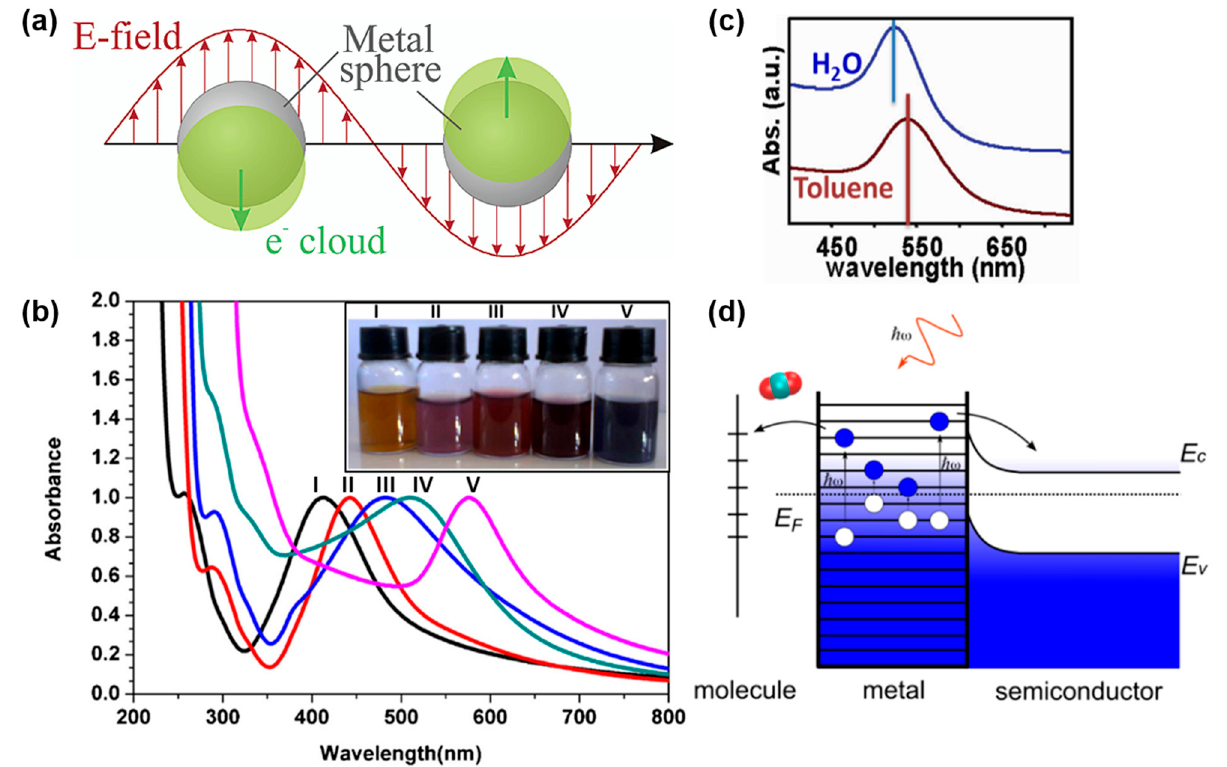
Figure 1. Localized surface plasmon resonance. ( a ) Schematic of the LSPR. ( b ) The effect of compo- sition: UV − Vis spectra of AgAu alloy NPs with different compositions. I: Ag, II: Au 0.25 Ag 0.75 , III: Au 0.50 Ag 0.50 , IV: Au 0.75 Ag 0.25 , V: Au. ( c ) The effect of the surrounding medium: spherical Au NPs in water and in toluene. ( d ) Energy diagram showing the excitation of carriers with photons inside the metal and their transfer to a neighboring molecule or semiconductor. ( a ) Reprinted with permission from ref. [2]. Copyright 2003 American Chemical Society. ( b ) Reprinted from ref. [40], Copyright (2014), with permission from Elsevier. ( c ) Adapted with permission from ref. [41]. Copyright 2012 American Chemical Society. ( d ) Reprinted with permission from ref. [38]. Copyright 2016 American Chemical Society.